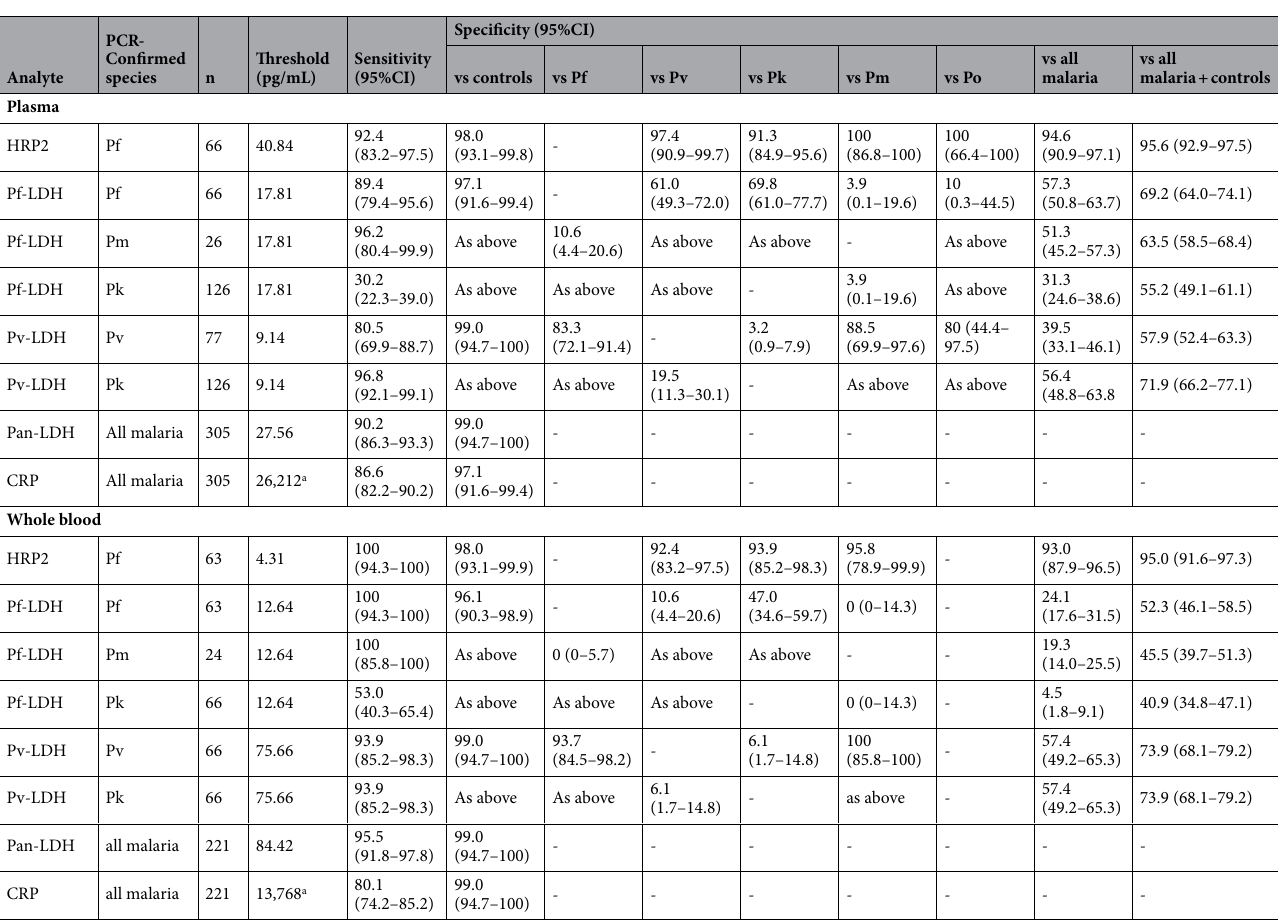
Table 2. Q-Plex™ Human Malaria assay diagnostic performance characteristics. PCR polymerase chain reaction, n number of samples, CI confidence interval, Pf Plasmodium falciparum , Pv Plasmodium vivax , Pk Plasmodium knowlesi , Pm Plasmodium malariae , Po Plasmodium ovale , HRP2 Histidine-rich protein-2, LDH lactate dehydrogenase, CRP C-reactive protein. a Units of